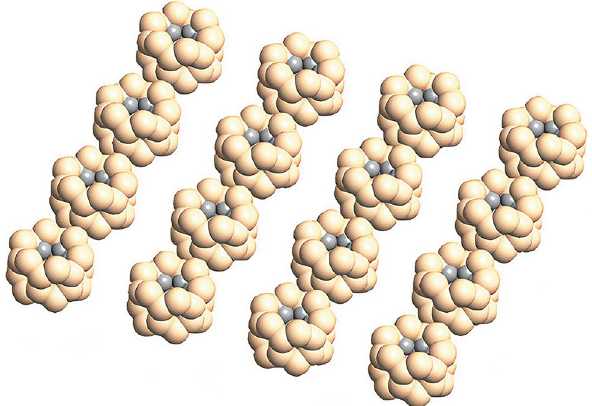
Fig. 2 Graphene/Si QD super